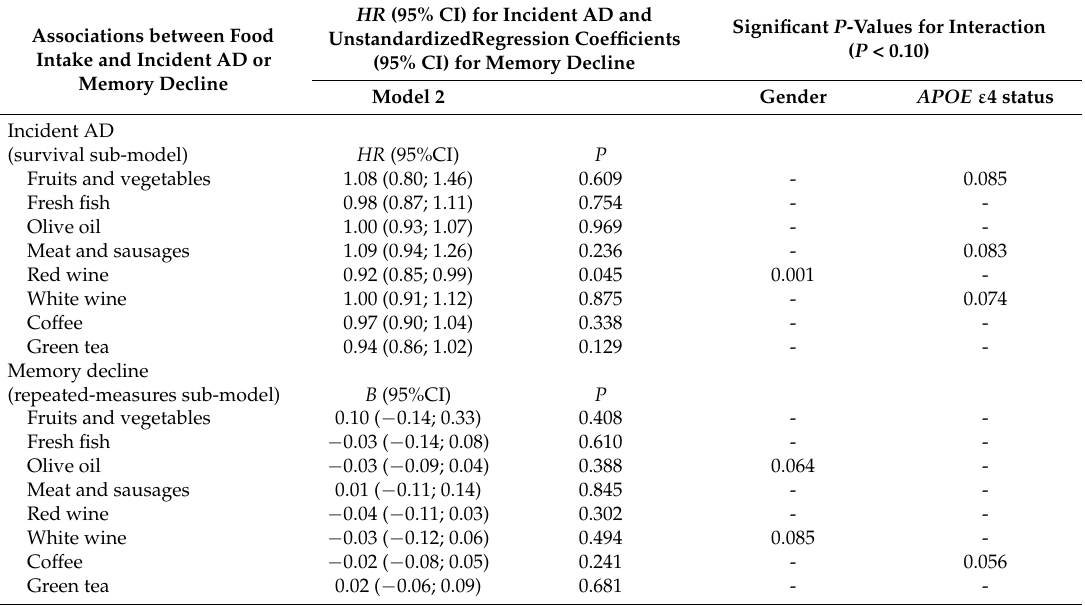
Table 3. Longitudinal joint modeling associations between food intake and incident AD and memory decline over a 10-year follow-up